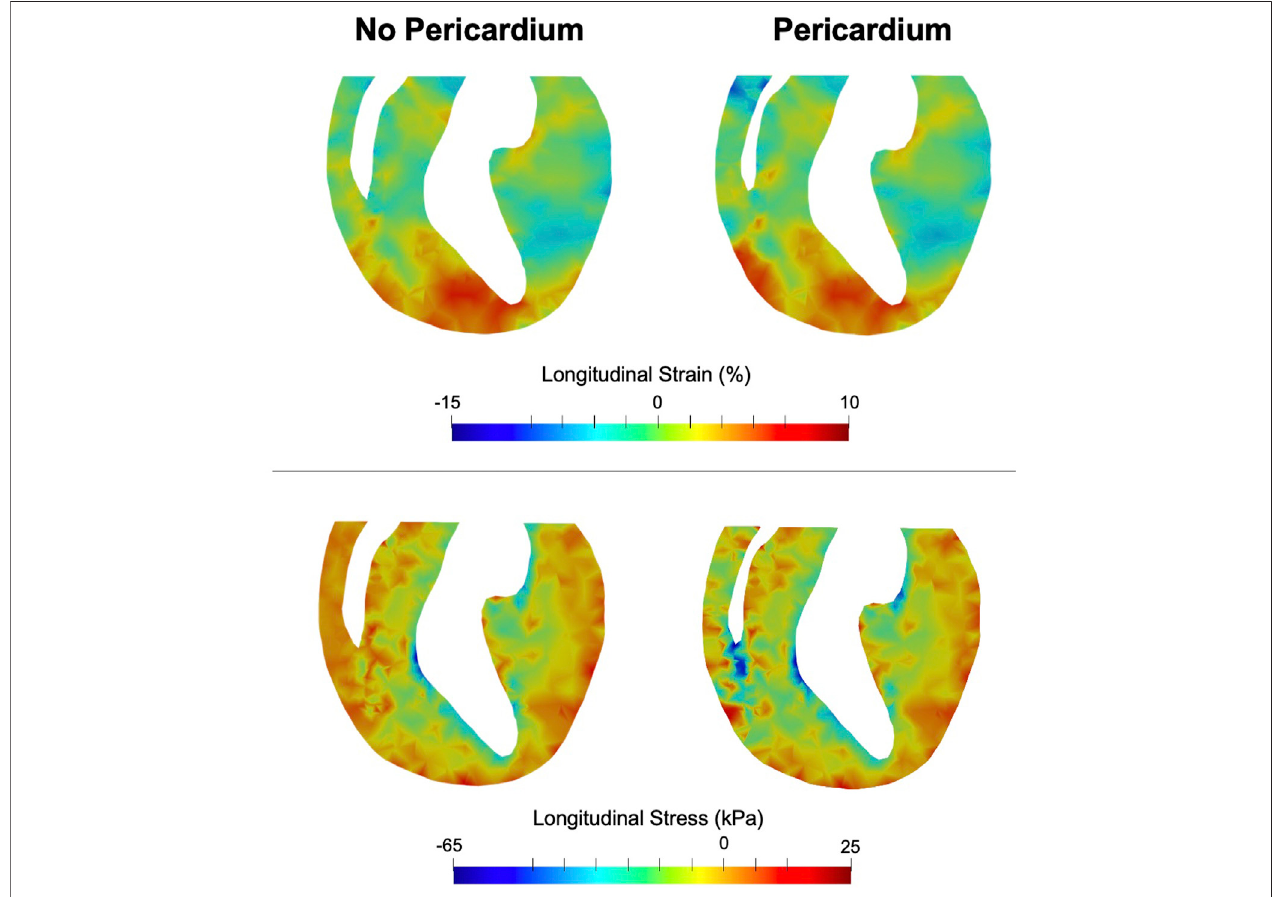
FIGURE5| End-systoliclongitudinalstrain(top)andstress(bottom)inalong-axiscrosssectionoftheheart.Greatereffectofthepericardiumonstresscanbeseen in the RV rather than the LV.